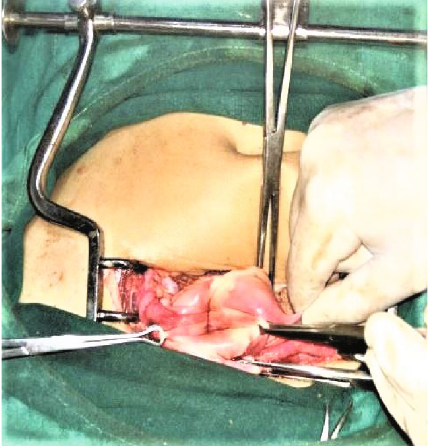
Figure 2: Cupping of the uterine content including fundus of the uterus, broad ligament, both ovaries, and round ligament.